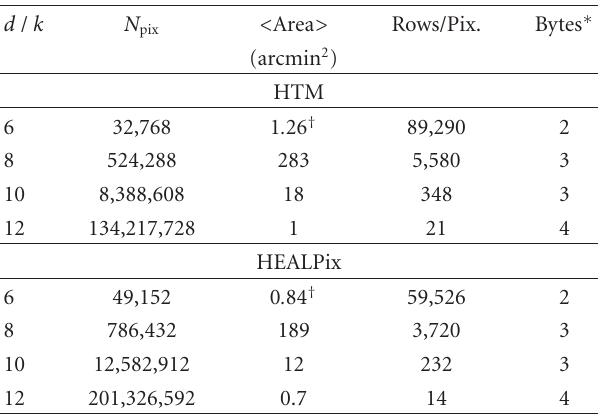
Table 3: Parameters for the HTM and HEALPix pixelization used in the